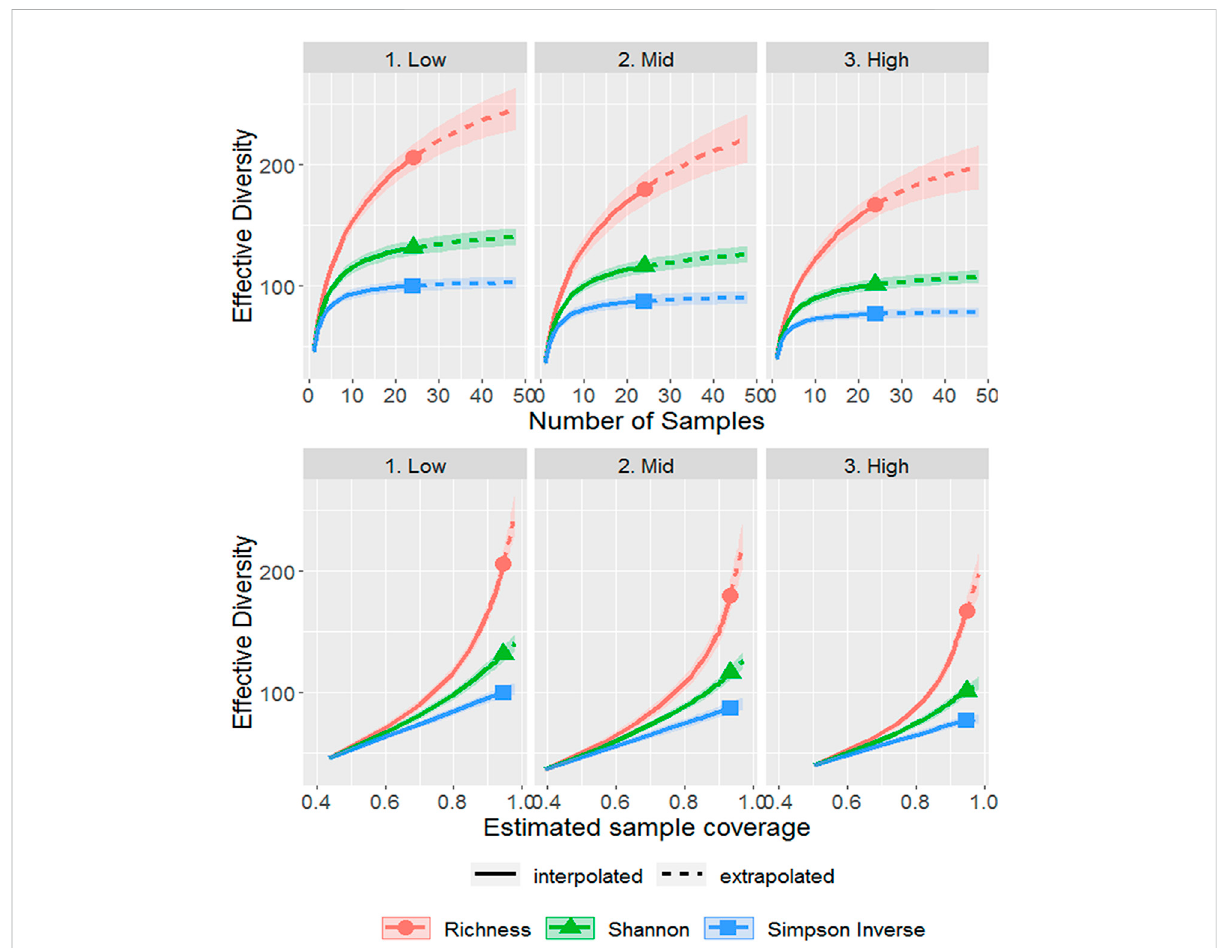
FIGURE 2 Sample-(top) and coverage-based (bottom) rarefaction curves for the metazoan community from marsh soil of three salinity zones (low, mid, andhigh salinity)calculated withthree metrics ofeffective diversity (Richness, Shannon,and Simpsoninverseindices).Extrapolation extended outto twice the number of samples. The shaded area around each curve represents the 95% con fi dence